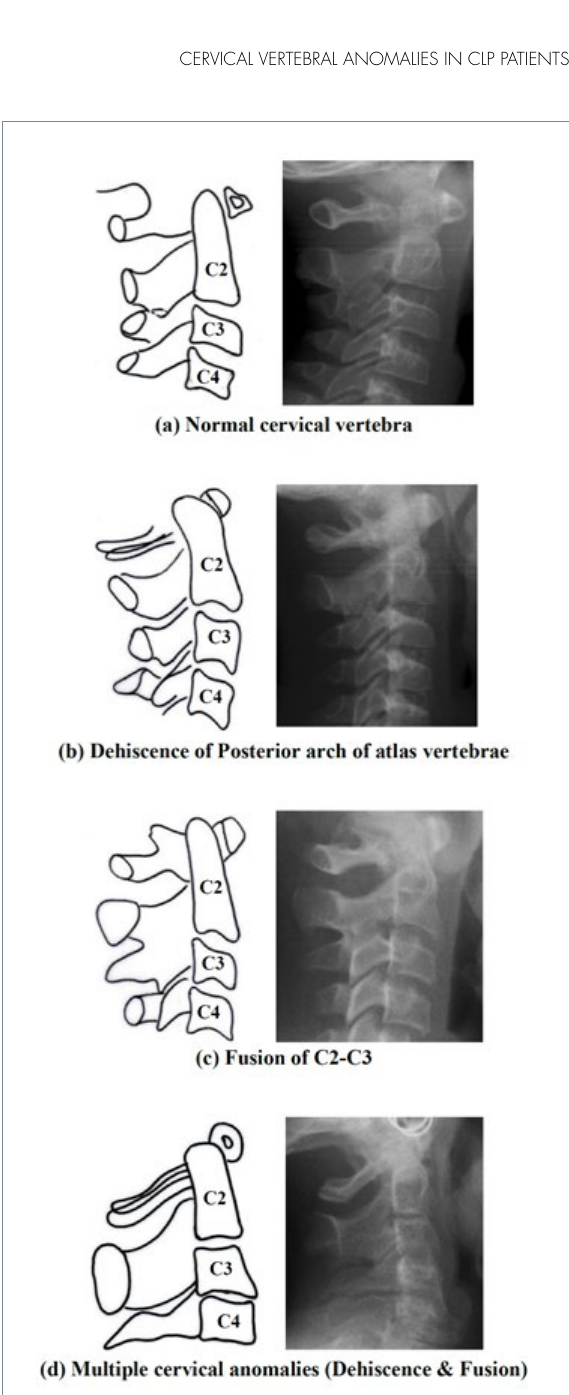
Figure 2. Pictorial representatives of normal, dehiscence, fusion and multiple anomalies of upper cervical